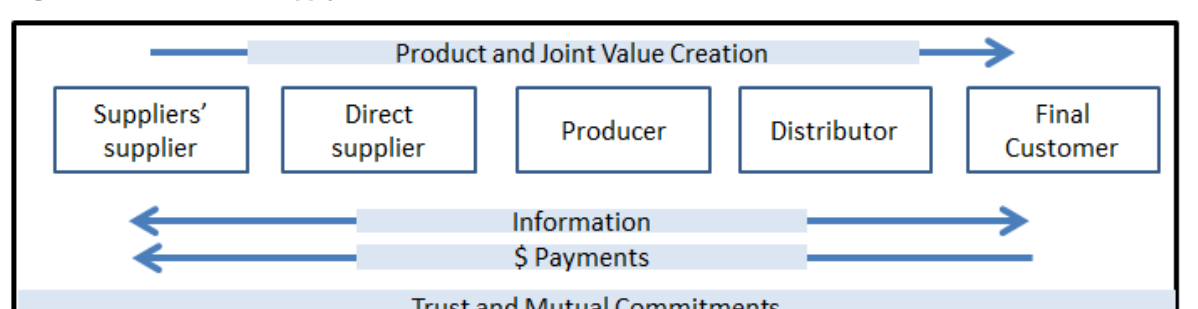
Figure 2. Collaborative Supply